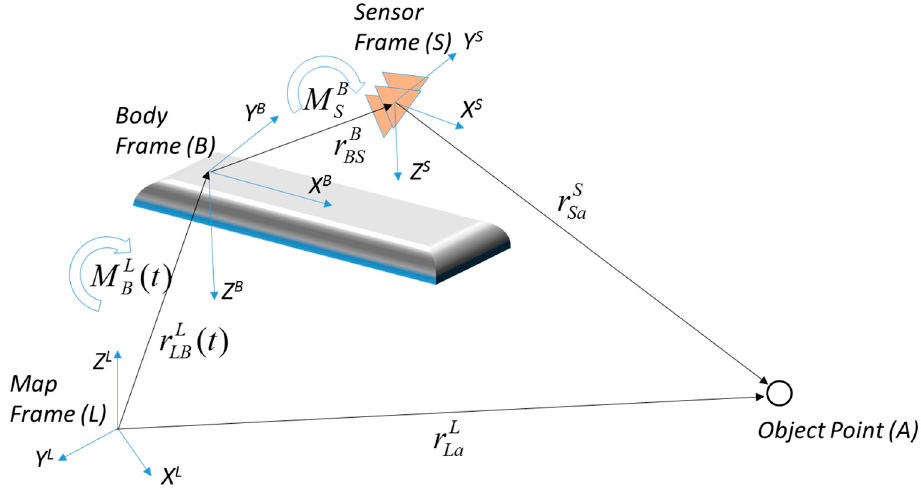
Figure 5. Conceptual model of mobile mapping system.